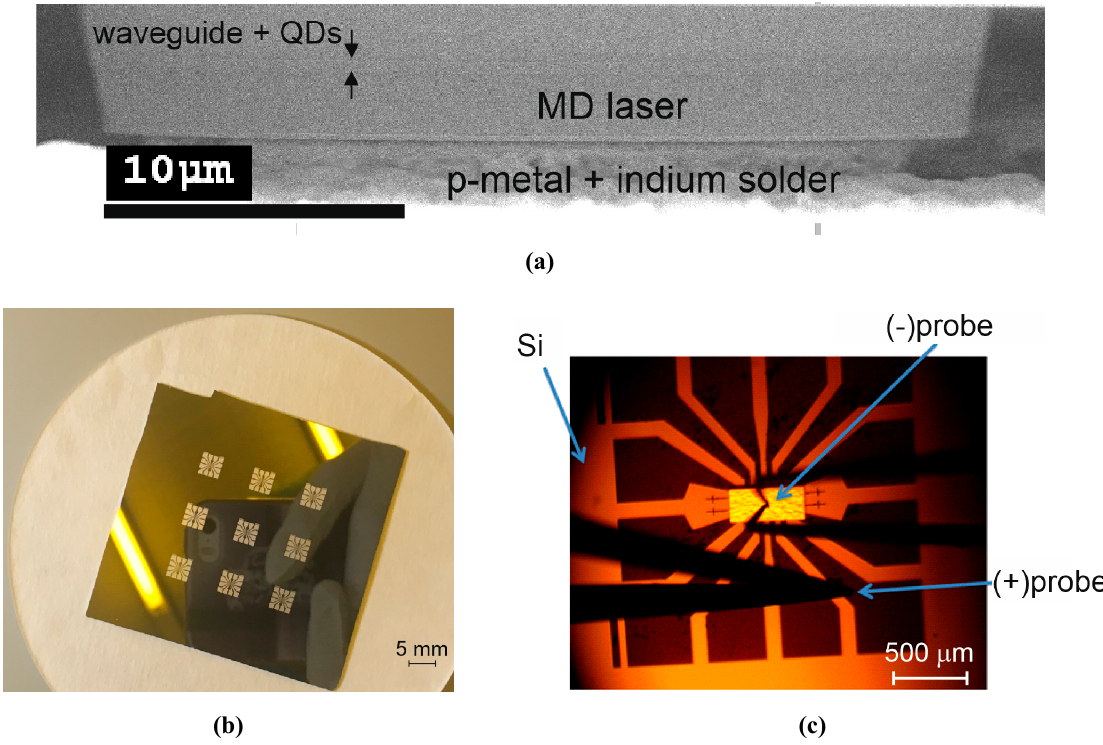
Figure 11. Contact pads formed on silicon substrate ( a ), scanning electron microscope image of the microdisk soldered onto Si substrate ( b ), electrical probes put on microdisk chip and contact pad ( c ) .